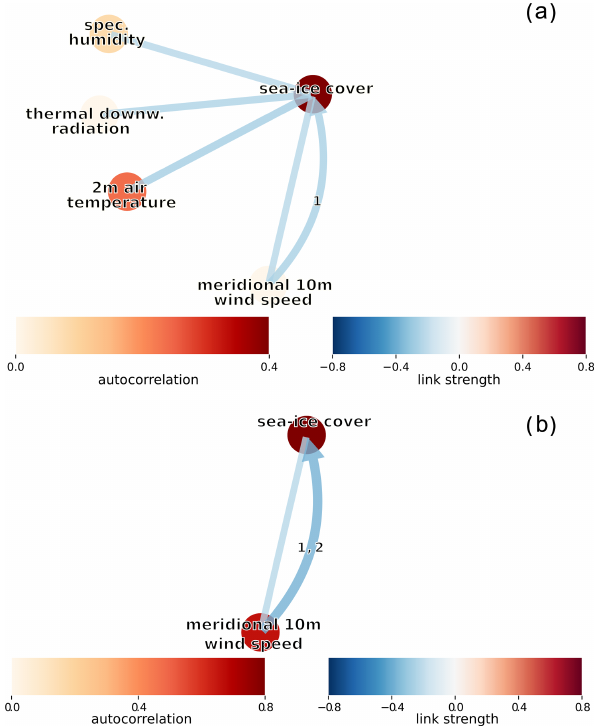
Figure 5. Causal-effect networks using atmospheric time series in- tegrated over the land for summer based on monthly means (a) and daily means (b) . The figure includes only those variables which have a significant connection to sea-ice cover. The color of nodes in- dicates autocorrelation. Straight lines show contemporaneous links, and arrows show causal links with the time lag indexed on the ar- row. The color of the arrows represents the sign and strength of the link. Blue means that more of one variable coincides with less of the other, whereas red means that changes in the connected variables have the same sign. The link is stronger the darker the color. Vari- ables with significant links to sea-ice cover are specific humidity (spec. humidity) averaged over the vertical column, 2m air tempera- ture (2m air temperature), meridional 10m wind speed (meridional 10m wind speed) and thermal downward radiation at the surface (thermal downward